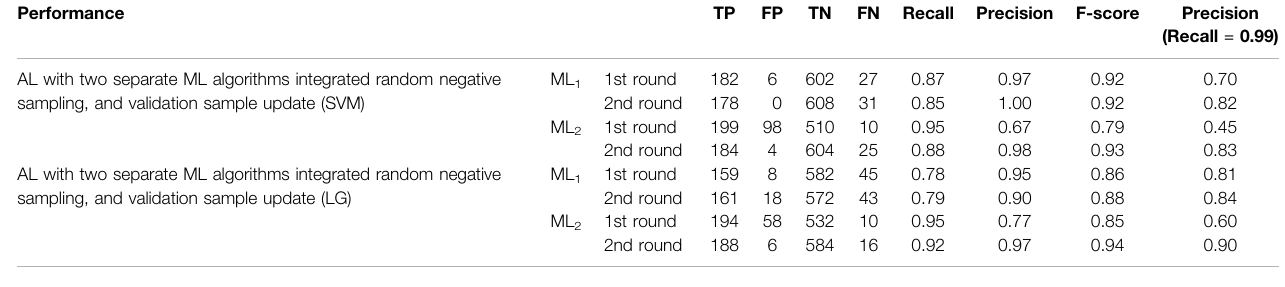
TABLE 5 | Performance of our proposed active learning (AL) method evaluated using SVM and LR. Performance